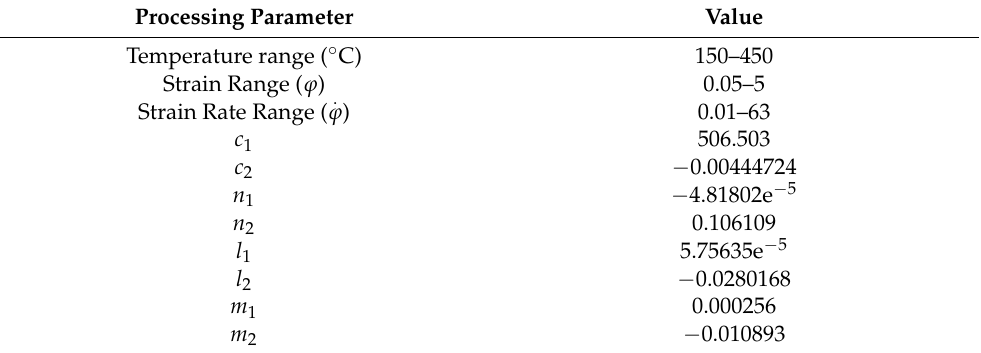
Table 1. The adopted model processing parameters for AA2011.